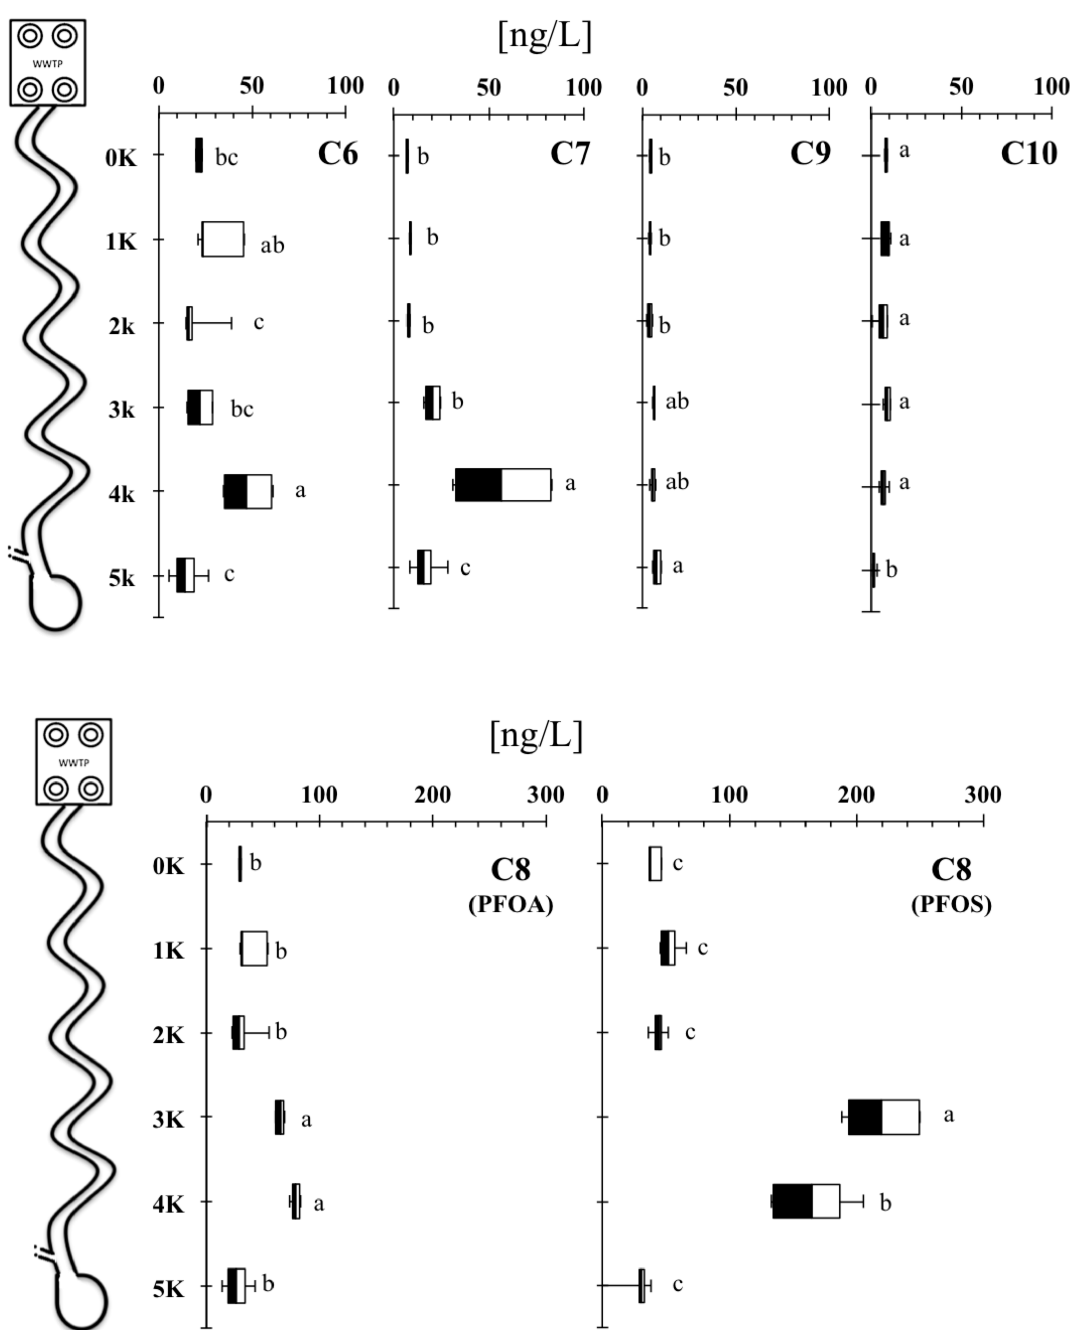
Fig 3. Longitudinal concentrations of PFAAs during the dry season. Box plot indicate minimum and maximum (bars), 25 quartile (white box), median (horizontal line), and 75 quartile (black box). Significantly different concentrations (ANOVA, p < 0.05) among sites are shown with different